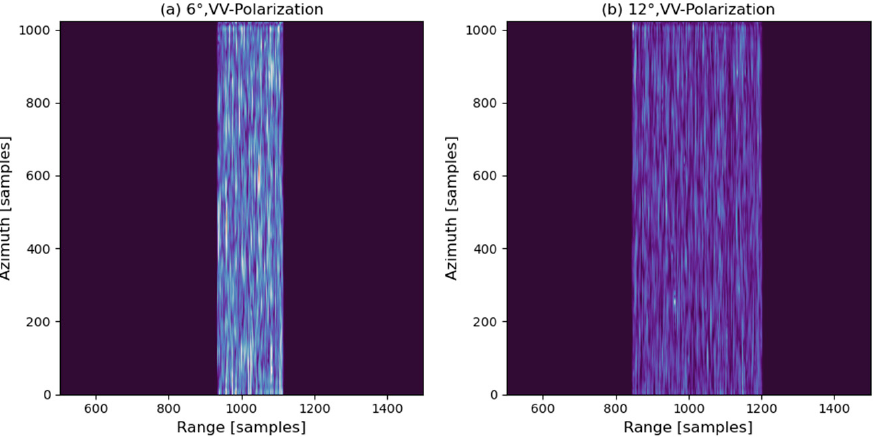
Figure 6. Sea surface scattering echo intensity image with wind speed of 10 m/s, swell wavelength of 150 m, wave height of 1 m, wind and swell directions of 0°, radar incidence angles of 6° and 12°, and azimuth angle of 0°. The horizontal axis represents range sampling points, and the vertical axis represents the number of pulses in the azimuth